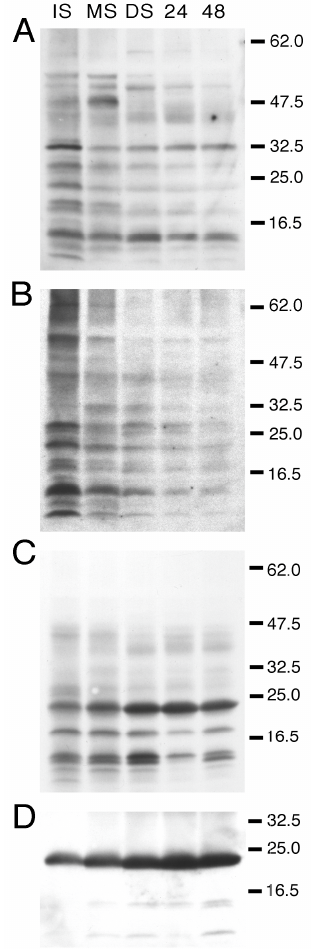
Figure 1. Western immunoblots probed either with ( A ) phosphoserine, ( B ) phosphothreonine, or ( C ) phosphotyrosine antisera. Blot lanes: IS, immature seed; MS, mature seed; DS, dry seed; 24, seed imbibed for 24 h; 48, seed imbibed for 48 h. Blot from panel C stripped and reprobed with TIP3 antisera shown in panel D . Position of molecular weight markers (kDa) indicated on right.